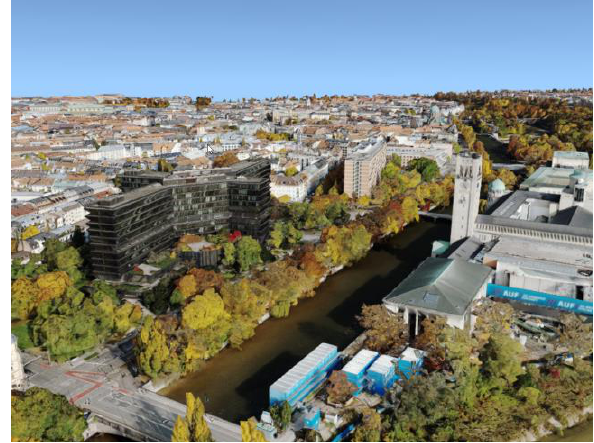
Figure 10: Contribution of sub-systems to hybrid data